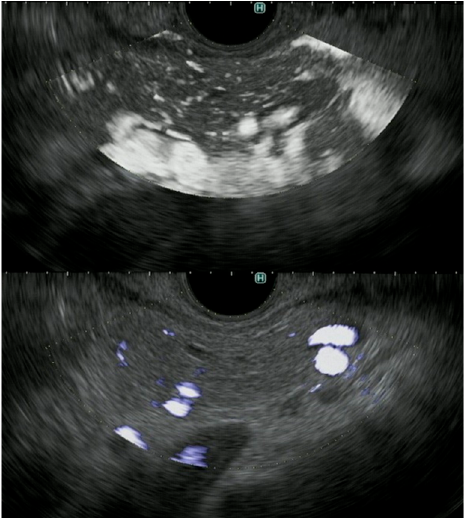
Figure 8. Detection of vessels in normal pancreas by DFI and e-FLOW endoscopic ultrasonography. DFI endoscopic ultrasonography ( upper ) provides better detection of vessels in normal pancreas than e-FLOW endoscopic ultrasonography ( lower ).